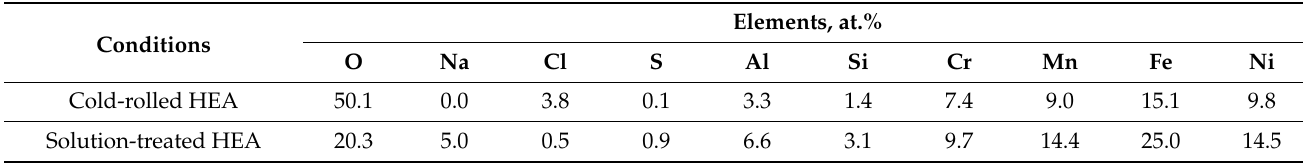
Figure 12. The SEM surface morphologies of the Fe 36 Mn 20 Ni 20 Cr 16 Al 5 Si 3 HEA as ( a , c ) cold-rolled and ( b , d ) solution-treated condition after subjected to 0.6 M NaCl + 0.5 M H 2 SO 4 solution. Table 3. EDX analysis of the corrosion products of the surface on cold-rolled (CR) and